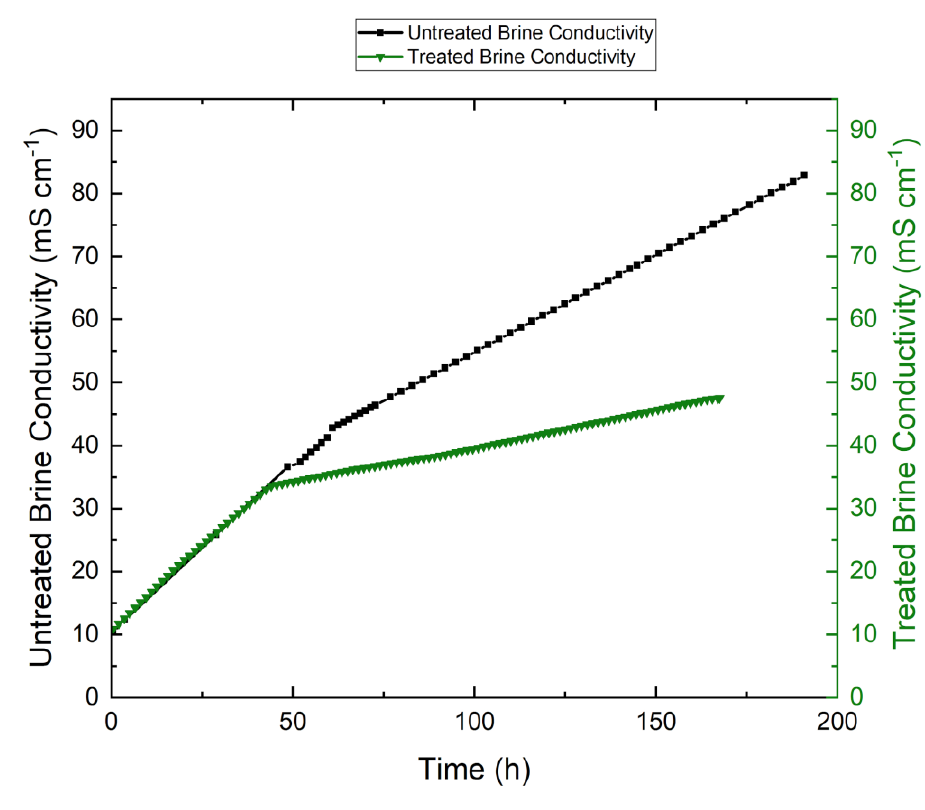
Figure A8. E ff ect of scaling on system Figure A8. Effect of scaling on system performance. Figure A8. Effect of scaling on system performance.